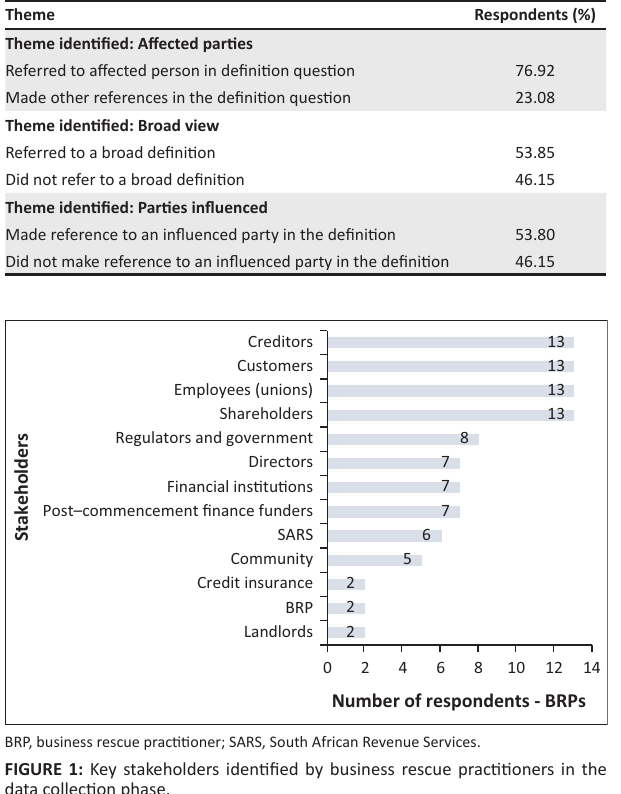
FIGURE 1: Key stakeholders identified by business rescue practitioners in the data collection